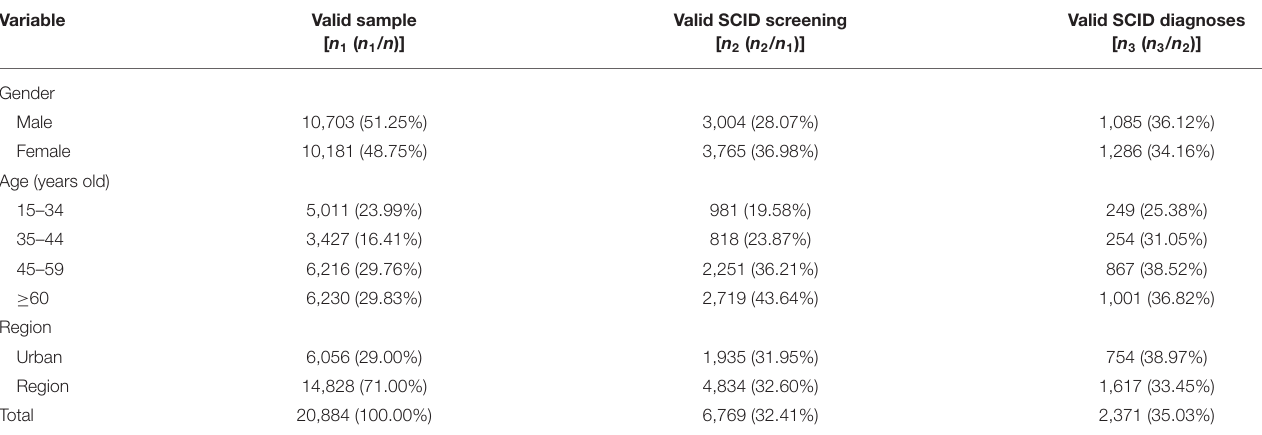
TABLE 1 | Social-demographic characteristics of the participants ( n =